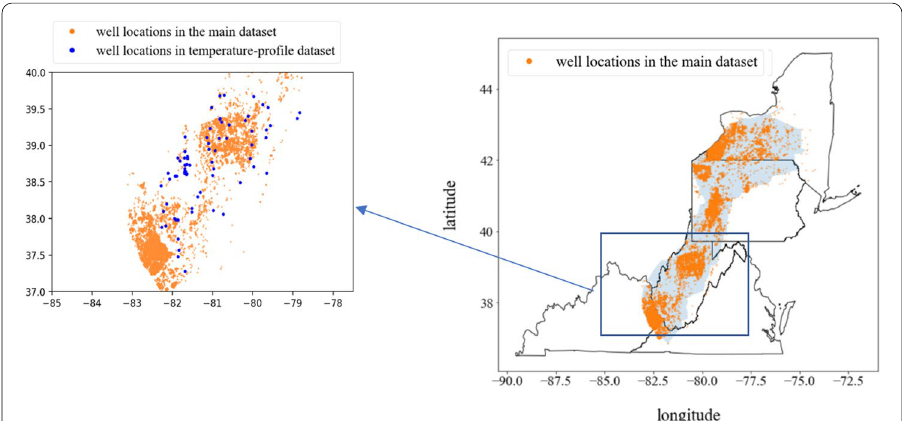
annotated using the blue